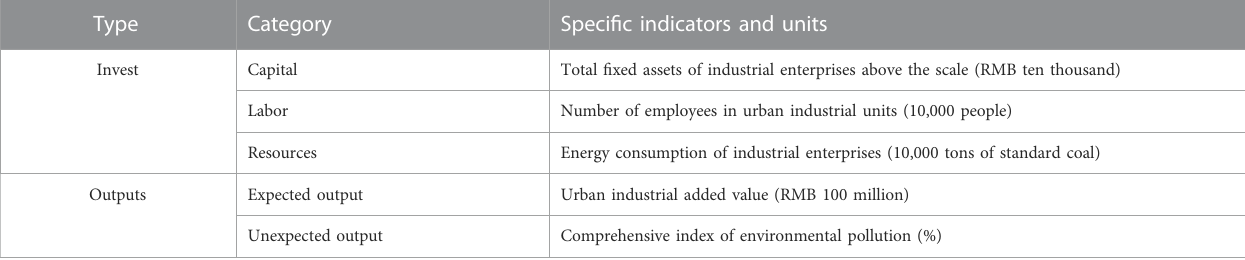
TABLE 2 Distribution areas and types of oil and gas cities in China. Region